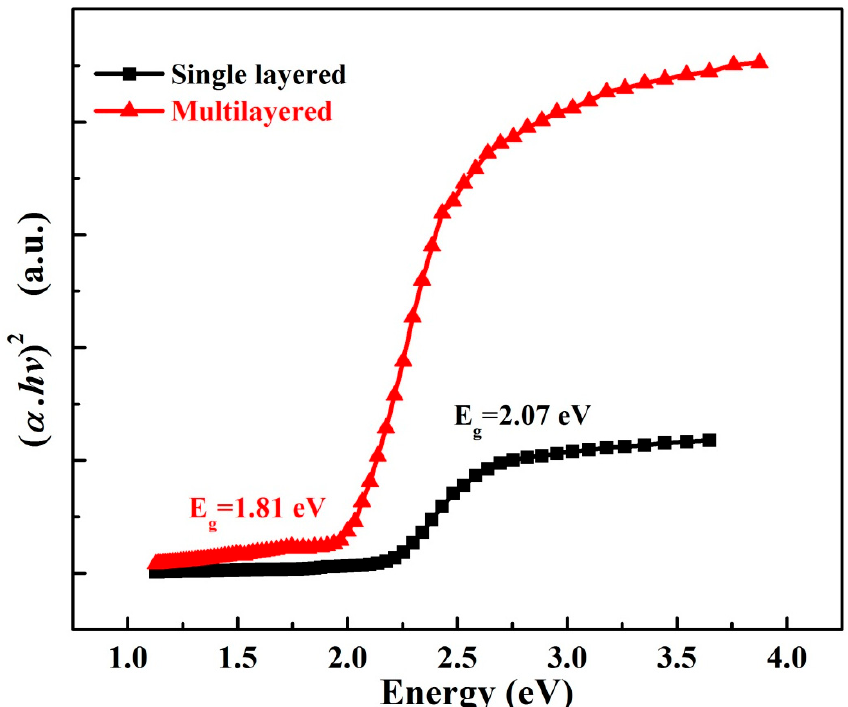
Figure 6. Tuac plot for single-layer and multilayered CH 3 NH 3 PbIBr 2 thinfilms. For the band gap estimation the Tauc plot method is used, and the band gap for single-layered thin films is 2.07 eV, which is consistent with the previous report [23]. Meanwhile, the bandgap of CH 3 NH 3 PbIBr 2 multilayered thinfilm is 1.81 eV. It shows that the bandgap is dependent on the thickness of the thinfilms. Graphically, photon energy ( hv ) on the x -axis and the other quantity ( α h ν ) 1/2 on the y axis can be written as: